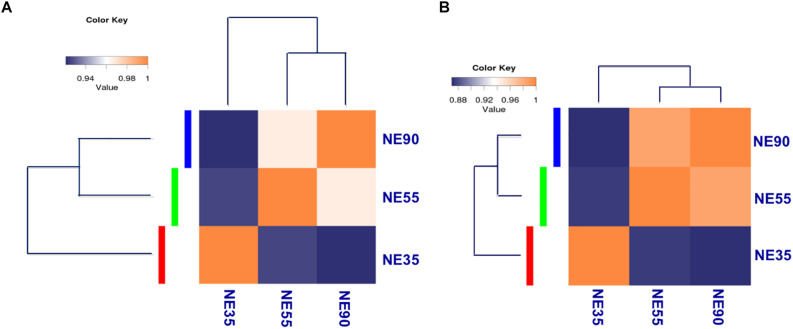
Transcriptome profiling reveals distinct developmental stages during embryonic myogenesis. Sample correlation matrix indicates a sharp transition of gene expression pattern (A) and miRNA expression pattern (B) between 35 and 55 dg. NE35, NE55, and NE90 indicate samples collected from NE group at 35, 55, and 90 dg, respectively. The correlation of gene expression patterns between distinct stages was analyzed by using cor in R package, and correlation matrix was plotted based on Pearson correlation coefficients between paired samples.